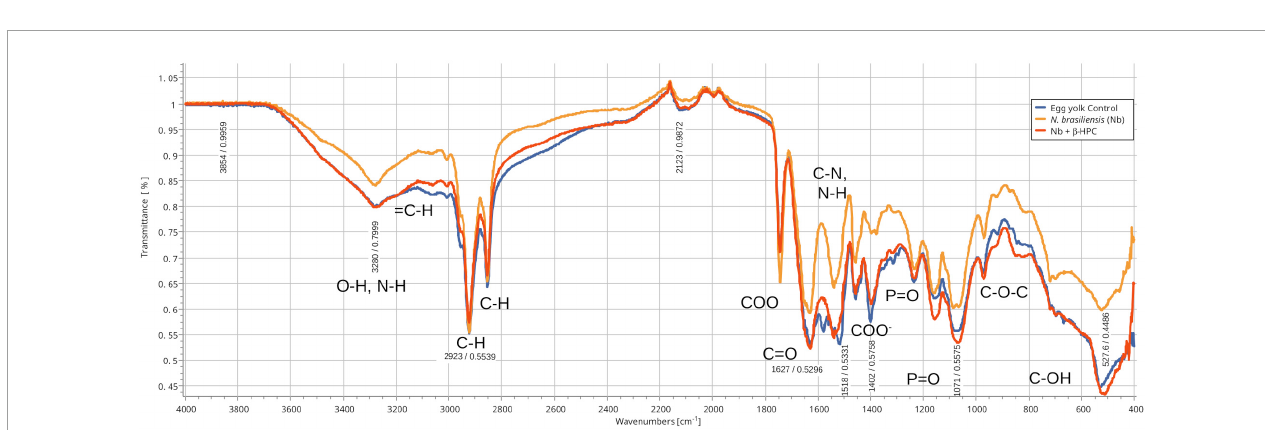
FIGURE5 Comparison of FT-IR spectra of the hydrolytic activity of N. brasiliensis on egg yolk with and without β -HFC. Culture medium alone, control (blue line), culture medium with 7 days of N. brasiliensis growth (orange line), culture medium with 7 days of N. brasiliensis growth + β -HPC (red line). A decrease in alcohol (O–H) signals is observed, as well as alkenes (= C-H, C = C), alkanes (CH 3 , C-H), and signals of the COO ester. In contrast, C-C and C-O-C had strong signals. At 3280 cm − 1 , O-H, and N-H stretches were detected. At 2923 cm − 1 , C-H strain signals were detected with C sp 3 hybridization (absorbance at all three: 0.55), and at 2850 cm − 1 , C-H was observed (absorbance at 3 0.64). At 1750 cm − 1 COO −− signals characteristic of esters were detected (0.71, 0.65, 0.71); amide I carbonyl ( C = O) signal was detected at 1627 cm − 1 ; amide II N-H, C-N at 1518 cm − 1 ; a signal characteristic of carboxylic acids (COO–) at 1400 cm − 1 ; and P = O at 1250 cm − 1 . A strong signal (phosphate P = O) was identified at 1071 cm − 1 . At 950 cm − 1 , there was a signal of alcohol (C–OH); beyond the fingerprint zone, there was also a robust C-OH signal at 550 cm − 1